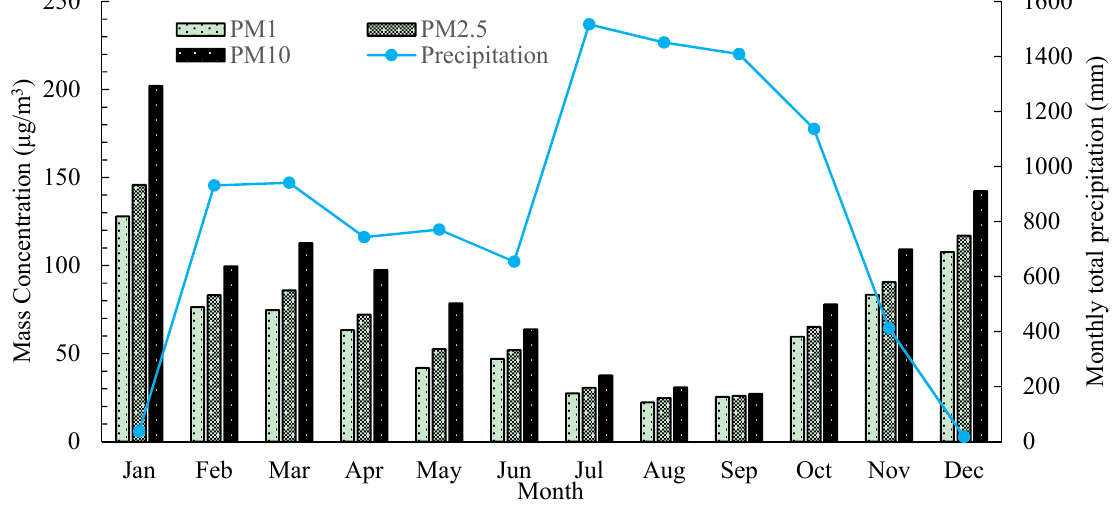
Figure 2. Monthly variations of PM 1 , PM 2.5 , and PM 10 mass concentration with monthly total